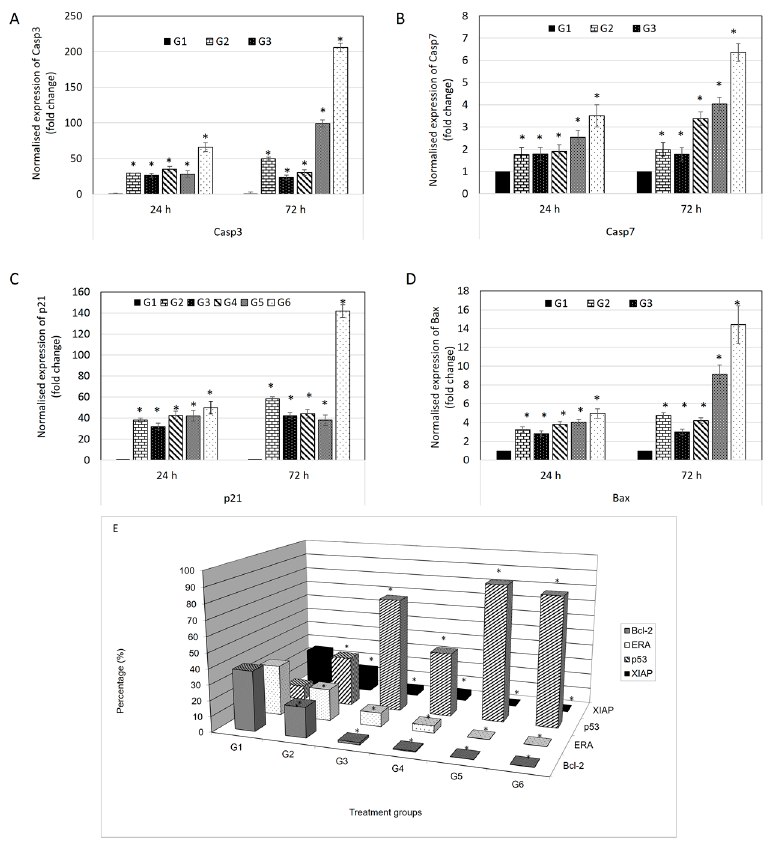
Figure 4. Normalised fold changes of ( A ) caspase 3; ( B ) caspase 7; ( C ) p21 and ( D ) Bax genes in MCF-7 cells after 24 and 72 h treatment; ( E ) Flow cytometry of protein expression of MCF-7 cell after 72 h